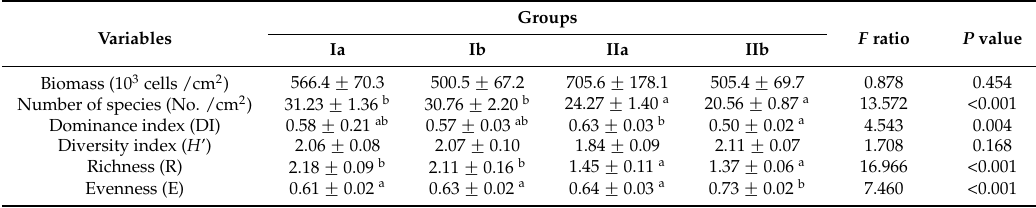
Table 1. Biological characteristics of Korean estuaries between 2012 and 2014. The estuaries were divided into four groups by cluster analysis based on diatom abundance. Small letters (a, b, and c) indicate Tukey’s test values. The P value is computed from the F ratio which is computed from the ANOVA